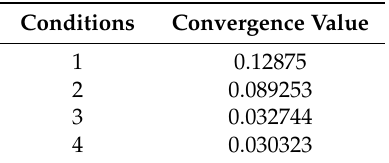
Table 4. The convergence results of the 4 conditions.